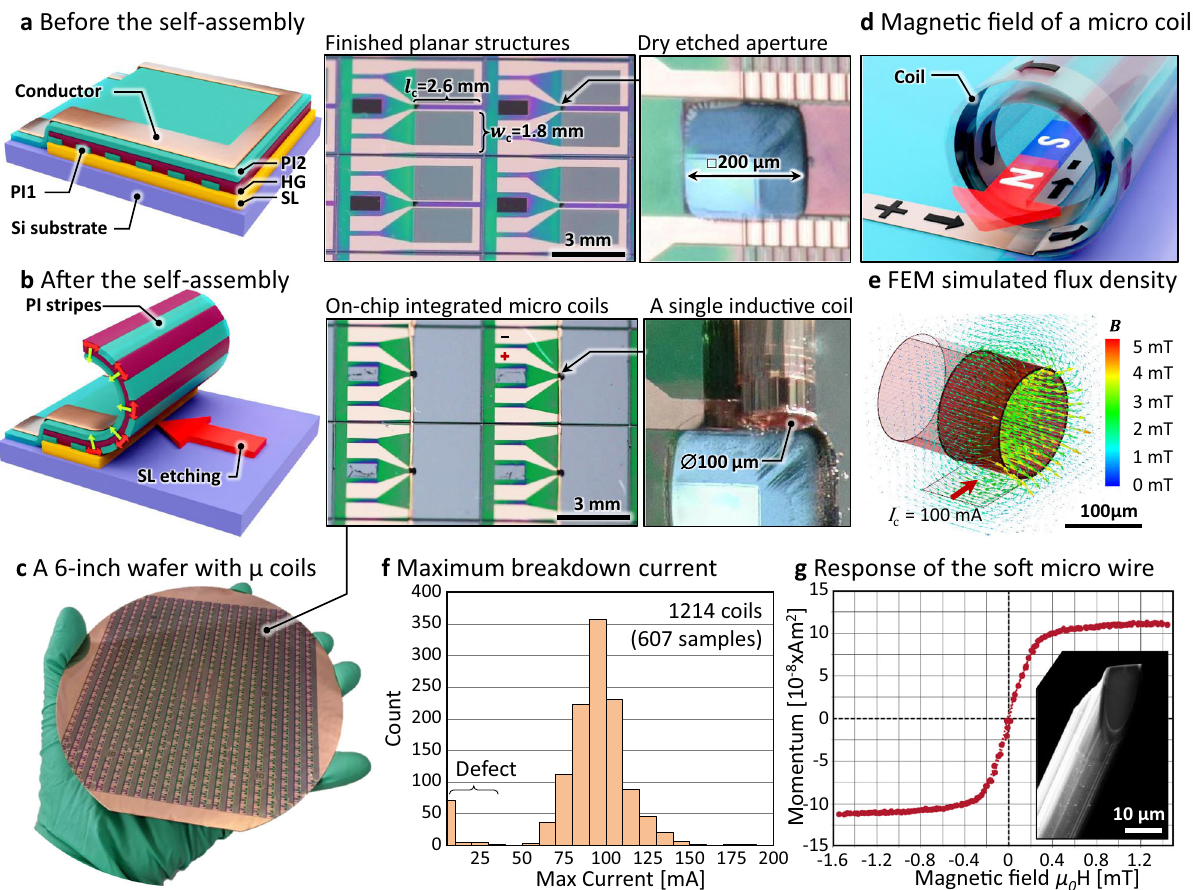
Fig. 2 Self-assembled micro-coils (exempli fi ed for coil pair sample design). a Sketch of the microfabricated layer stack and structures before the self- assembly process with a micrograph of four adjacent structures on the wafer. The planar structure has a width of w c = 1.8 mm and is as long as the conductor stripe (length l c = 2.6 mm) with a width of 50 µ m, which later on forms the micro-coil. The structures contain openings forming an aperture for the electron beam. b Sketch and micrograph of the self-assembled micro-coils which are produced by etching of the sacri fi cial layer (SL) and swelling the hydrogel layer (HG). The conducting metal layer is placed on top of a polyimide layer (PI) c 6-inch wafer with 1069 out of 1214 functional integrated micro- coils. d Generation of magnetic fi eld with a micro-coil when current passes through the conductor. e FEM simulation of the magnetic fl ux density generated by a coil driven by I c = 100 mA current shows that the coil can provide high fi elds of about 3 – 4 mT. f Distribution of the maximum breakdown current for the micro-coils fabricated on one wafer reveals a mean break down current of 93.0 mA. g The axial magnetic response of the soft ferromagnetic microwire (inset) with the transversal anisotropy reveals almost linear hysteresis free fi eld dependence in the range from − 0.2 to 0.2 mT external fi fi eld B t for an electron of relativistic mass m e , velocity v , and elementary charge e can be used to estimate the magnetic fi eld generated by the µMCPO. Figure 3f shows that α ranges from − 1.04 mrad at − 100 mA to 0.64 mrad at 100 mA, which